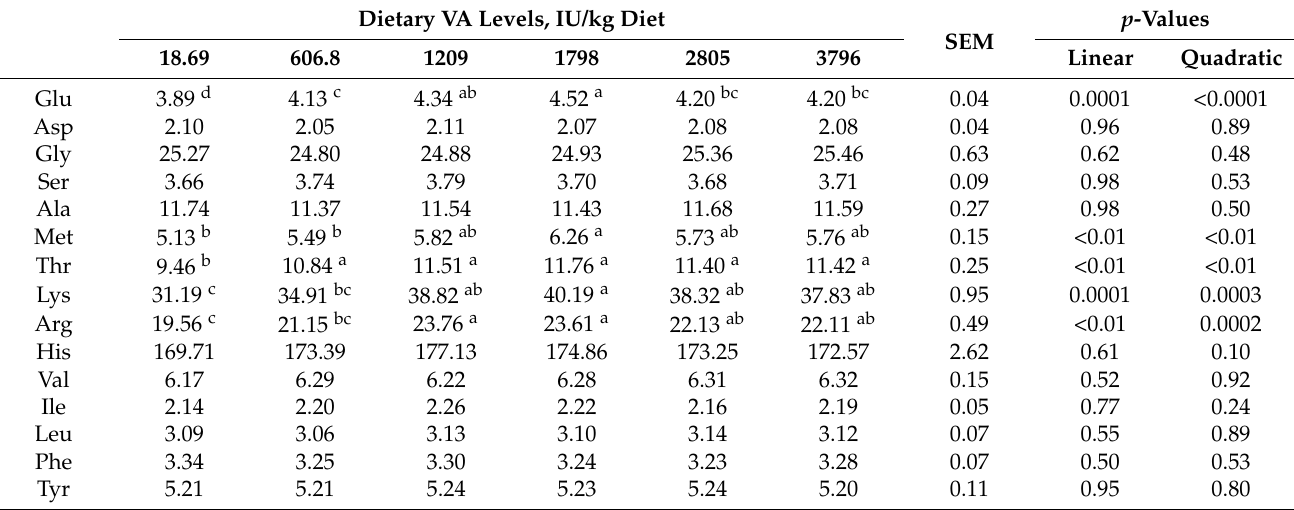
within a row, means without a common lowercase superscript differ ( p < 0.05). Table 4. Effects of dietary vitamin A on muscle amino acid composition (mg/100 g dry) of on-growing grass carp 1 . Dietary VA Levels, IU/kg